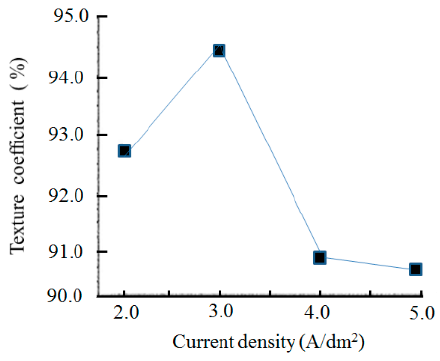
Figure 10. Texture coefficients of (200) crystal orientation at various current densities.